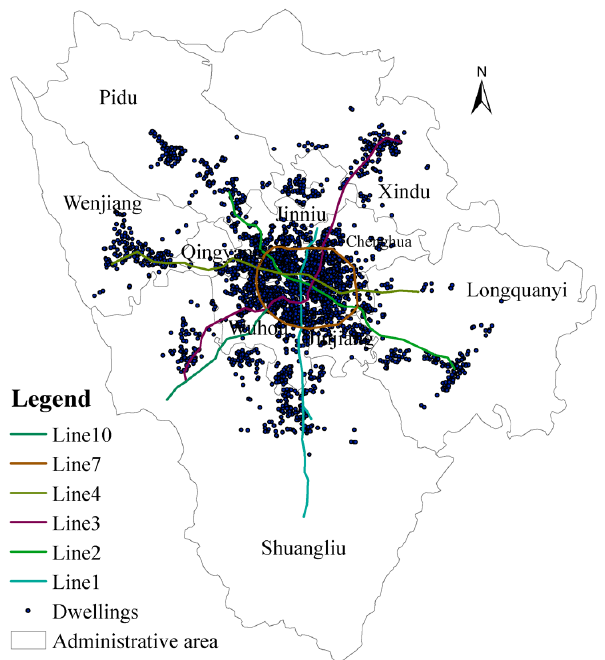
Figure 1. Spatial distribution of subway lines and housing samples in Chengdu.